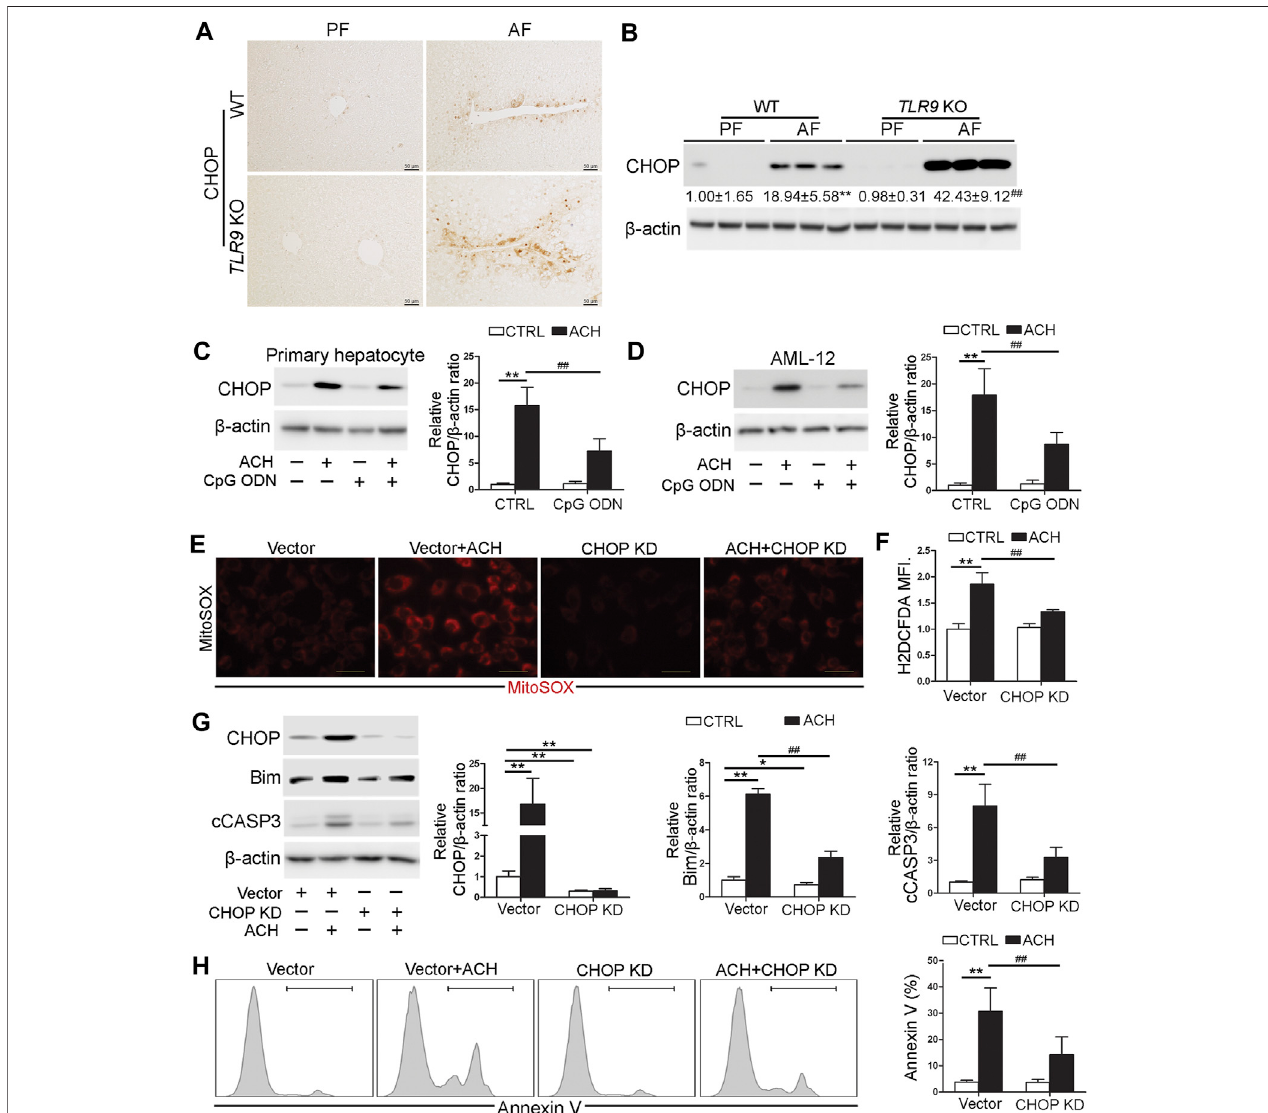
FIGURE 5 | CHOP was involved in the protective role of TLR9 signaling in acetaldehyde-indued cell injury and oxidative stress. (A,B) TLR9 KO and wild-type male mice were pair-fed or alcohol-fed for 8 weeks plus a single binge of ethanol (4 g/kg) before 4 h of tissue collection. (A) Immunohistochemistry analysis of hepatic CHOP expression. Scale bars: 50 μ m. (B) Western boltting of hepatic CHOP. (C) CHOP protein levels in primary hepatocytes. (D) CHOP protein levels in AML12 cells. (E) Immuno fl uorescentstainingofmitochondrialROSusingMitoSOXprobe. (F) FACSanalysisofhepatictotalROSusingH2DCFDAdye.Dataarethesummaryofthe mean fl uorescenceintensity(MFI). (G) Western boltanalysisofCHOP, Bim, andcCASP3 levelsinAML12cells. (H) FACSanalysisofapoptotic celldeathrepresentedby AnnexinVpositivecells. (A,B) ** p < 0.01vs.WT/PFmice; ## p < 0.01vs.WT/AFmice.PF,pair-fed;AF,alcohol-fed. (C – H) * p < 0.05,** p < 0.01vs.control; ## p < 0.01vs. ACH treated